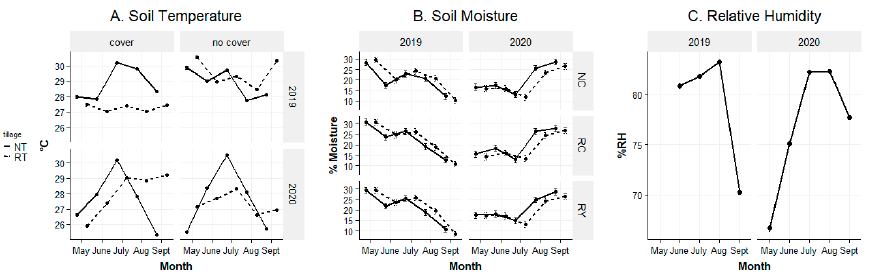
Figure 1. Soil Temperature, Soil Moisture and Relative Humidity, soil temperature ( A ), soil moisture ( B ), and relative humidity ( C ).